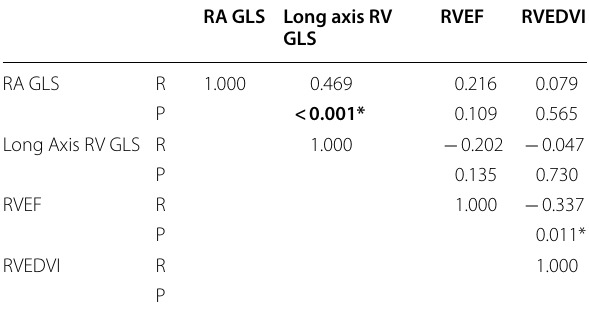
Table 12 Comparison between two groups of